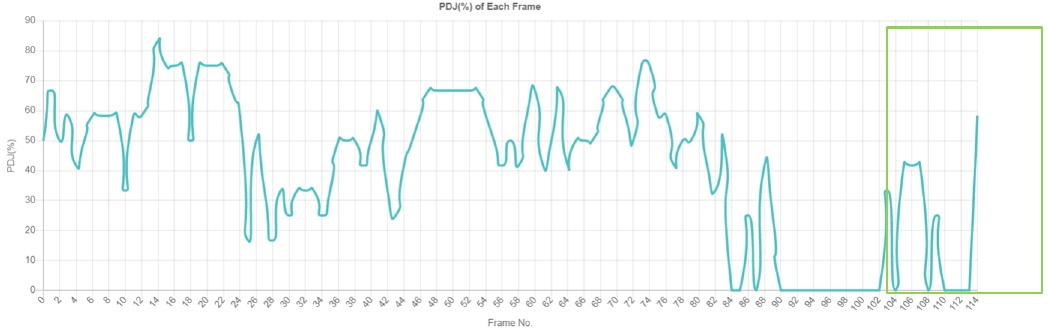
Figure 17. Line graph of PDJ values for OpenPose in each frame in Action 1 (baseball pitch).